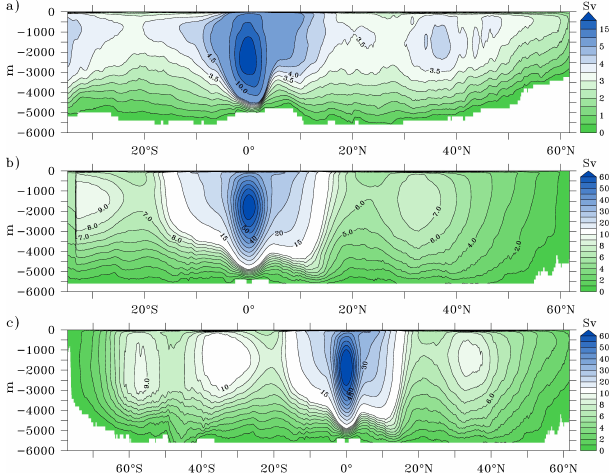
Fig. 6. Standard deviation of the MOC for the 1976 to 2001 pe- riod for experiment B025. The values are obtained from 5-day av- erages. (a) Standard deviation for the Atlantic. The contour interval is 0.5Sv for values of up to 5Sv. For standard deviations > 5Sv the contour interval is 5Sv. (b) As (a) for the Indo-Pacific. For values < 10Sv ( > 10Sv) the contour interval 1 Sv (5Sv). (c) As (b ) for the global MOC.